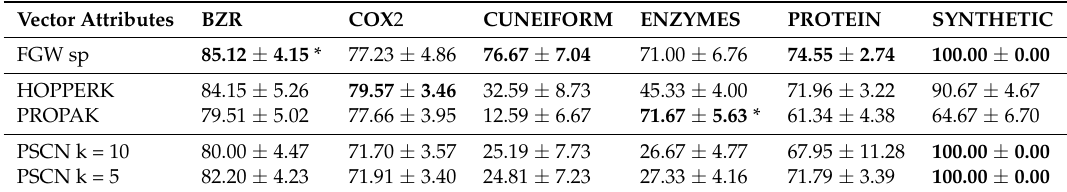
Table 1. Average classification accuracy on the graph datasets with vector attributes.